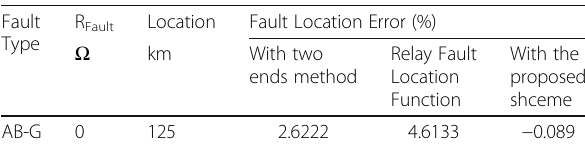
Table 2 Comparison of accuracy with different fault location method